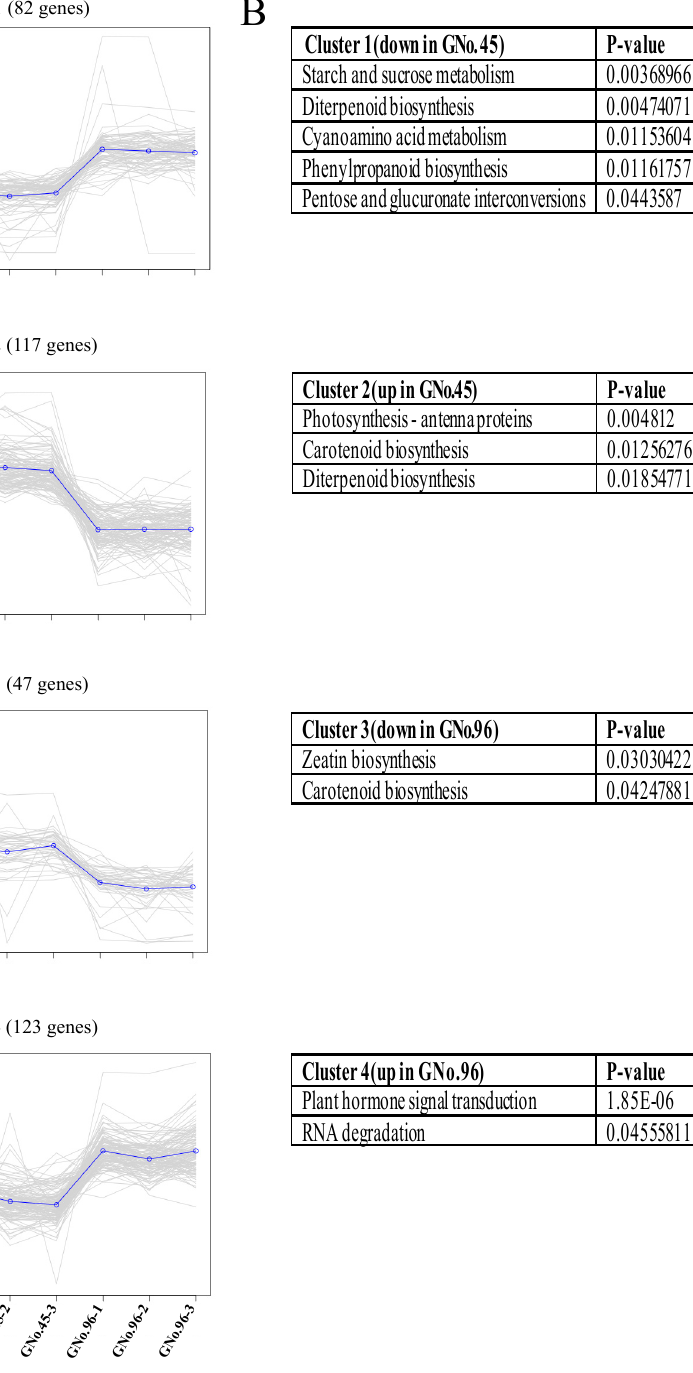
Figure 5. Overview of gene expression clusters calculated by K-means clustering. ( A ) Pearson correlation was used to identify four clusters involving a total of 369 genes with significant expression profile changes in at least one sample. ( B ) GO analysis of DEGs in each cluster, p < 0.05 (FDR adjusted).